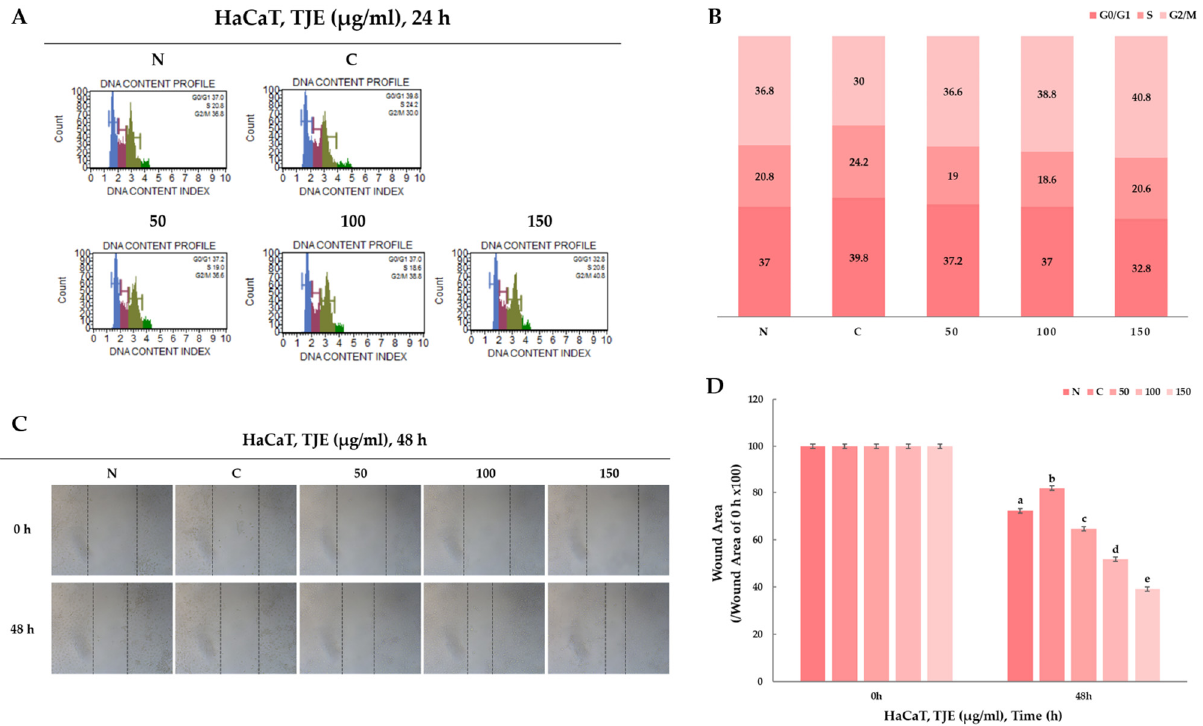
Figure 3. ( A , B ) TJE occurs in cell cycle progression. G2/M phase ratio increased compared with to the positive control. Cell cycle arrest effect was measured by flow cytometry. ( C ) Cell motility was measured using a wound-healing assay. Representative images of the cell migration were